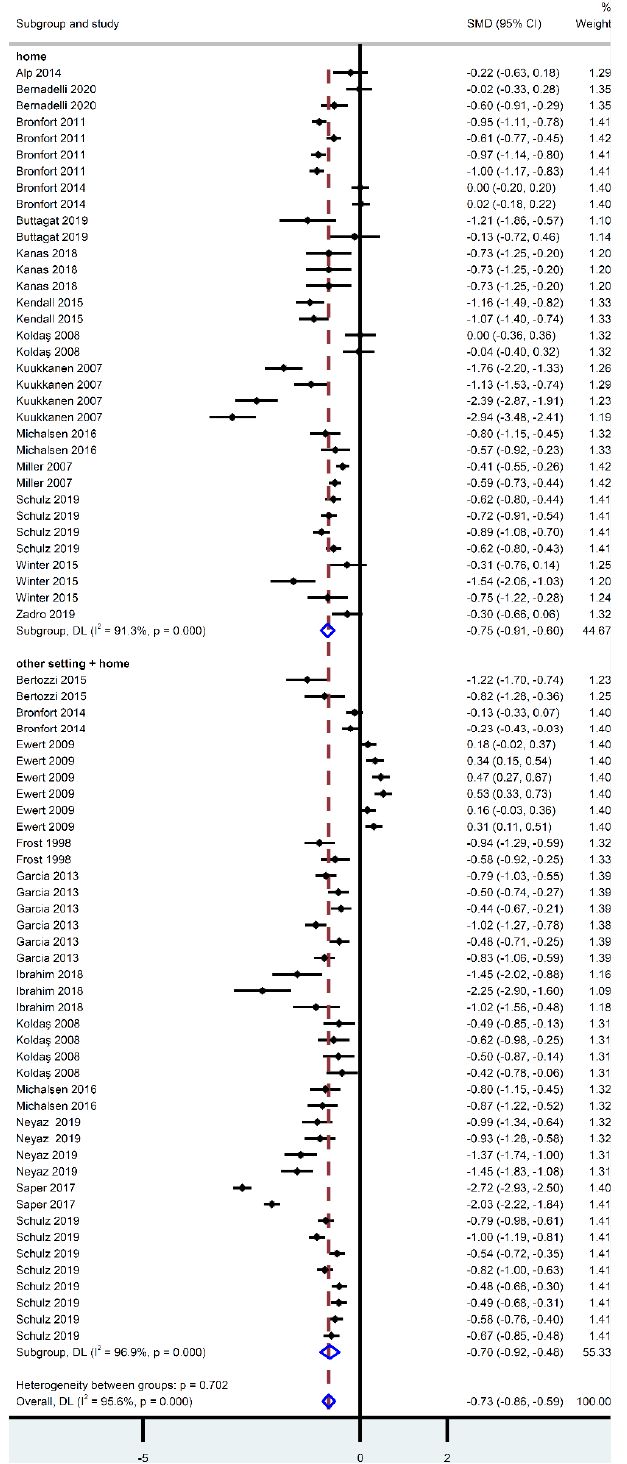
Figure A1. Meta-analysis on the effect of home-based exercise on functional limitation, stratified by setting (exclusive home-based training versus home-based and other setting).